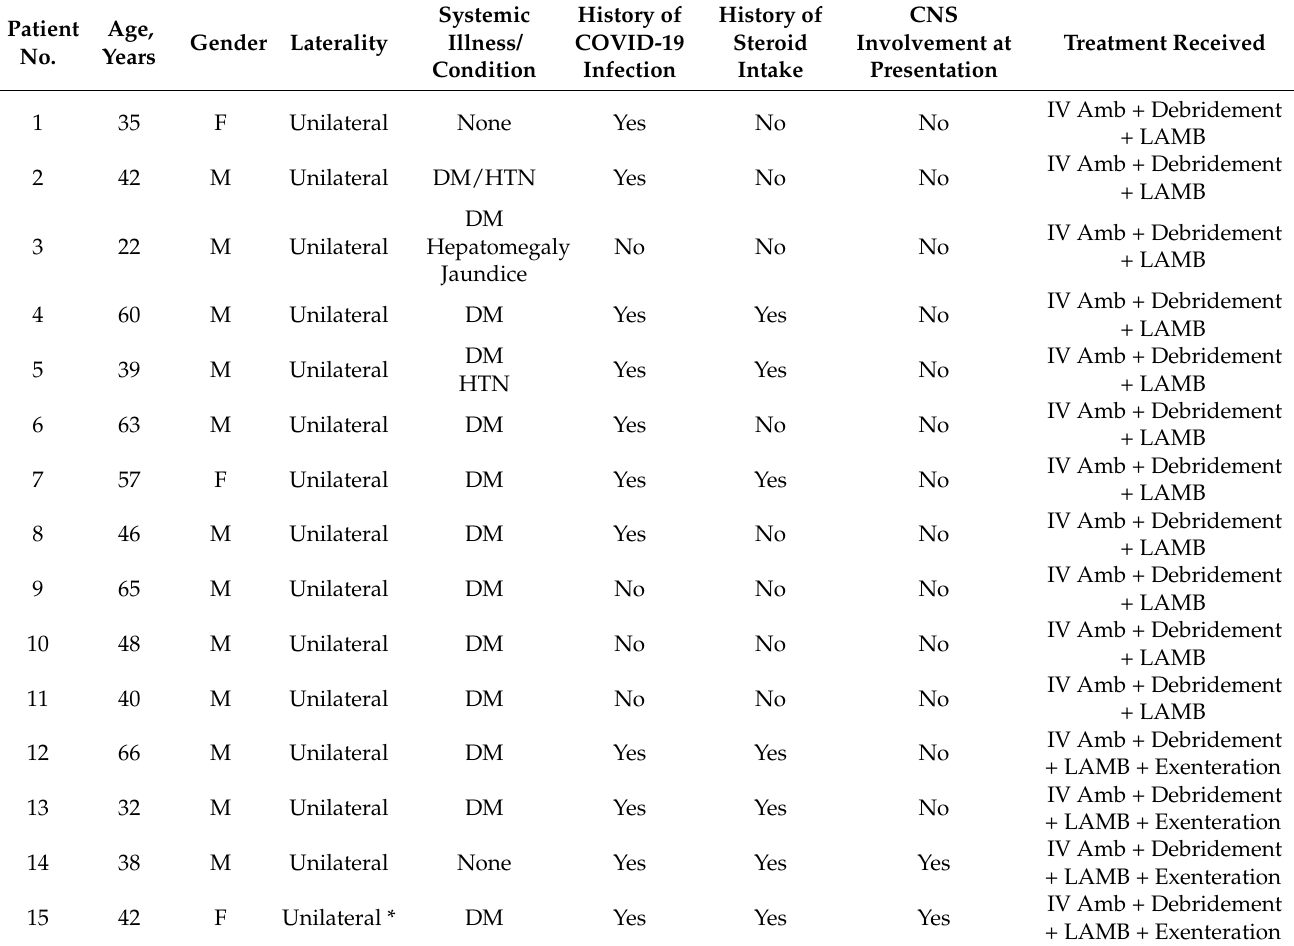
Table 1. Clinical and demographic features of patients with vison-threatening ROCM.